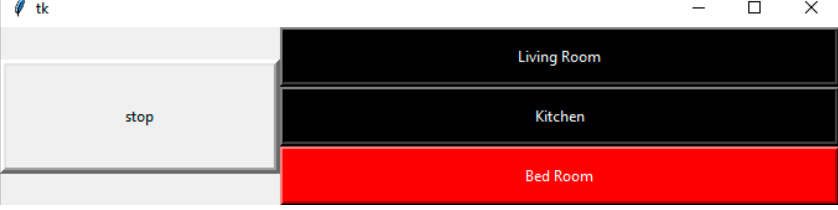
Figure 4. User interface selected the desired destination “Bed Room” using the EEG command.